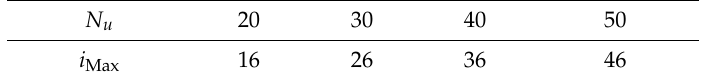
Table 2. The output value of i Max with respect to the number of users ( N t = 100 ) . N u 20